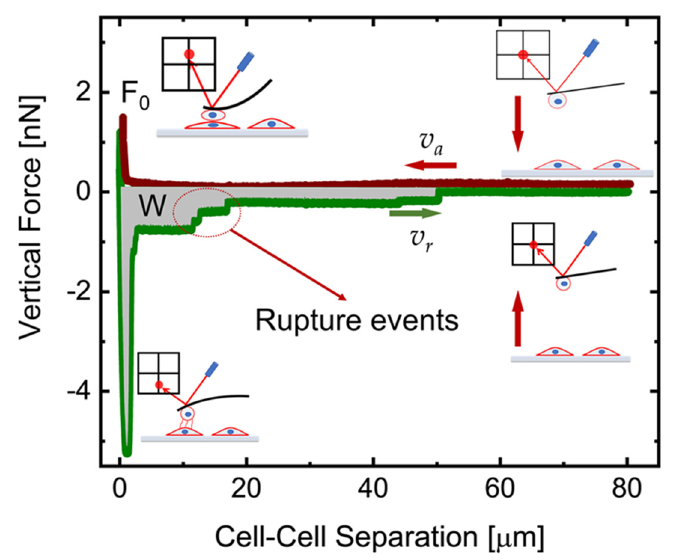
Figure 1. Typical force–distance (F–D) curve acquired in cell–cell force spectroscopy (CCFS). The curve starts when the CHO cell attached to a tipless cantilever is positioned at 80 µm on top of a selected target CHO cell. This is represented as the cartoon in the top right. The atomic force microscope (AFM) cantilever then begins to move towards the target cell with a constant approach speed v a (red line) reaching the preset setpoint force value F 0 (see cartoon in the top left). At this point, cells are kept in contact having constant either the applied force or the position (delay mode). After the contact time (delay time, τ ), the AFM cantilever is pushed-away from the target cell